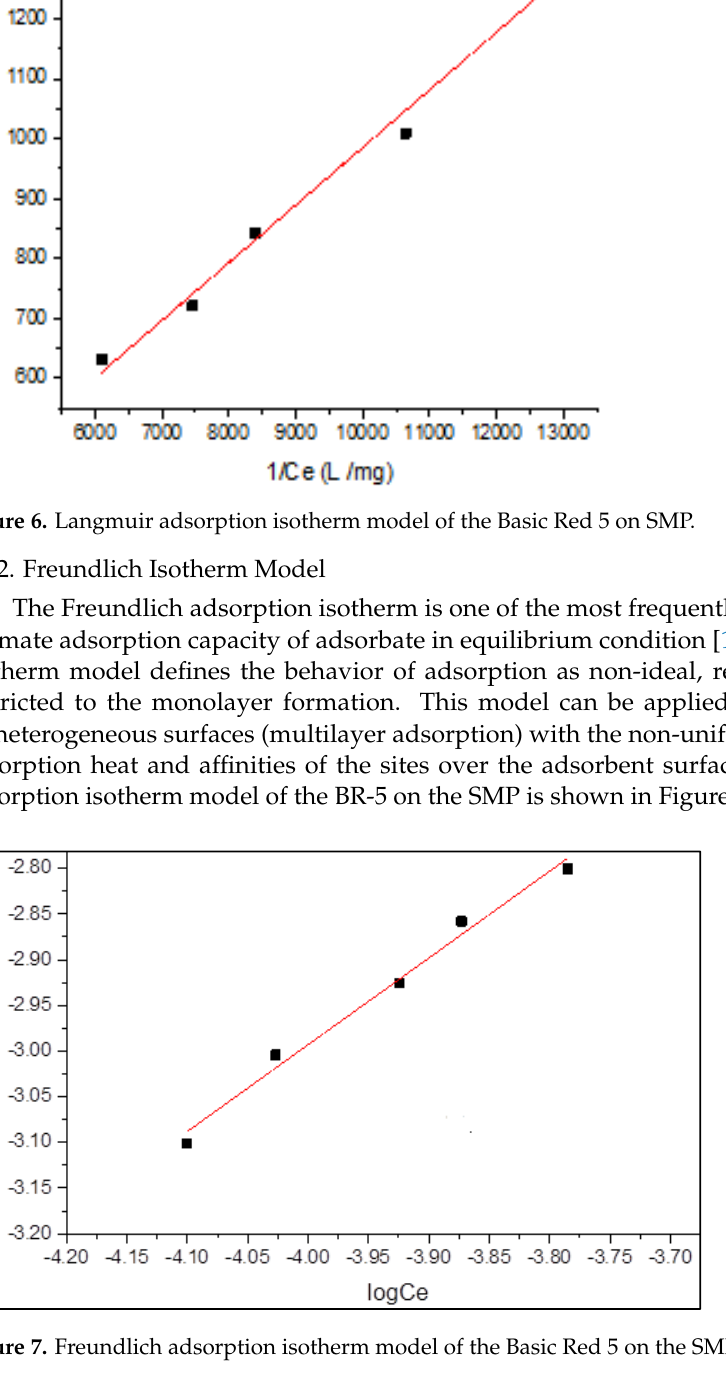
Figure 7. Freundlich adsorption isotherm model of the Basic Red 5 on the SMPs.